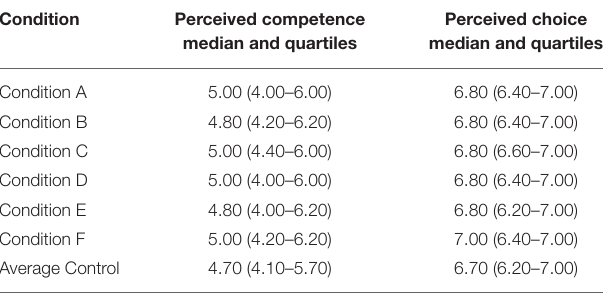
TABLE 7 | Perceived competence and perceived choice—medians and quartile values.